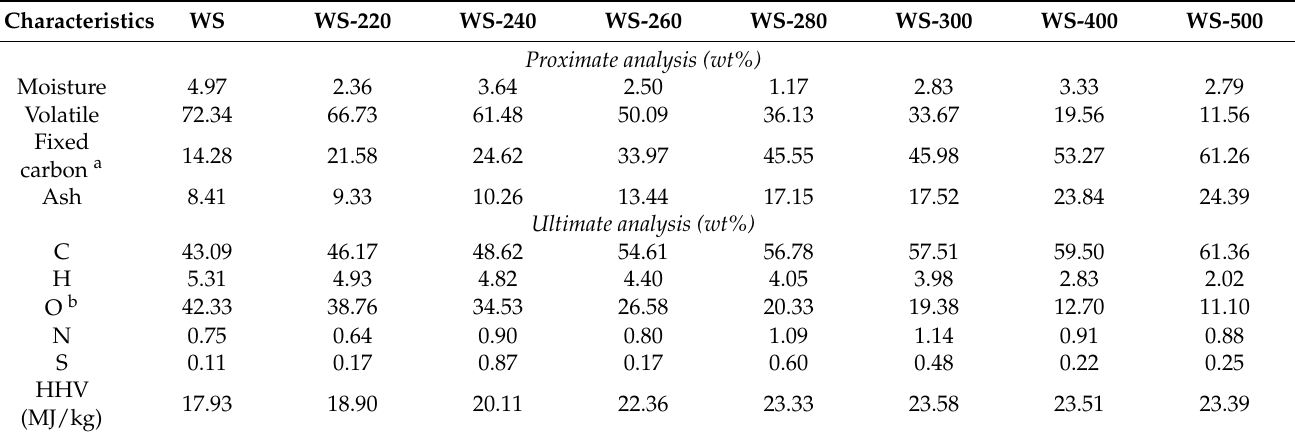
Table 1. Proximate and ultimate analysis of raw and torrefied/carbonized wheat straw.